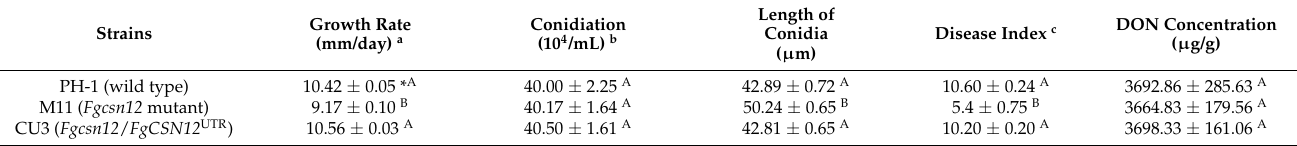
with results from at least three replicates. The data were analyzed with Duncan’s pairwise comparison. Different uppercase letters indicate significant differences ( p =